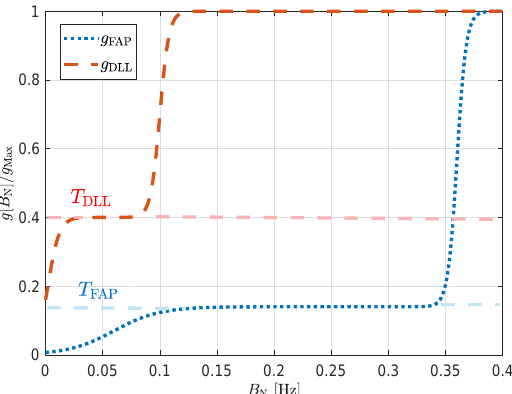
Figure 4. Selected normalized weighting functions for LBCA FAP and LBCA DLL